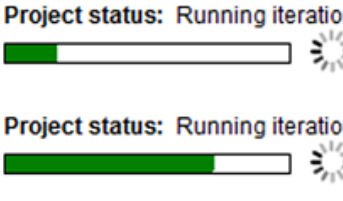
Fig. 8. SWAT calibration in multiple process